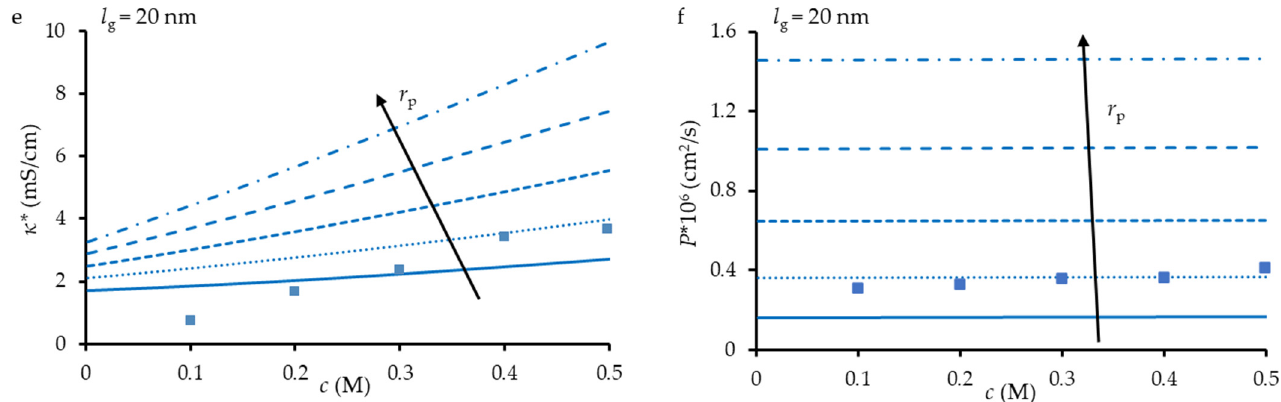
Figure 4. Experimental (dots) and simulated (lines) results for the electrical conductivity ( a , c , d , e ) and diffusion permeability ( b , f ) of TEM#811 as a functions of NaCl concentration. Simulations are made for r p = 8, 12, 16, 20 and 24 nm at l g = 0 ( a , b ), 5 nm ( c ), 10 nm ( d ), and 20 nm ( e ).